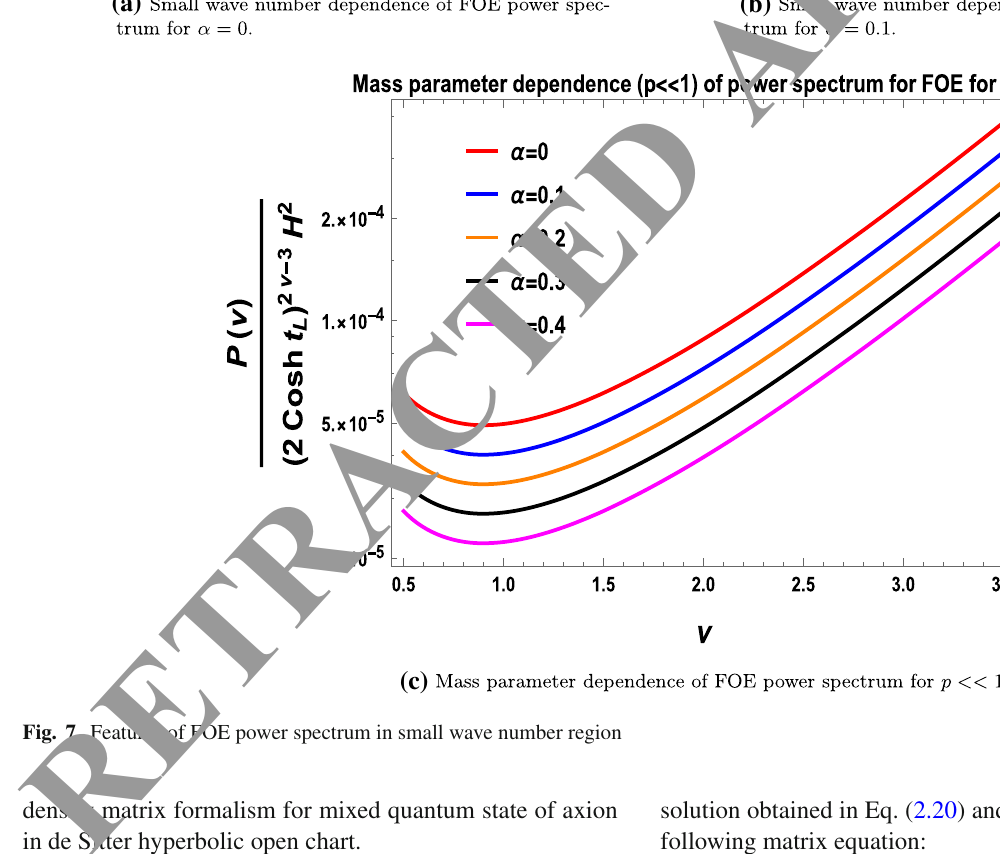
Fig. 7 Features of FOE power spectrum in small wave number region